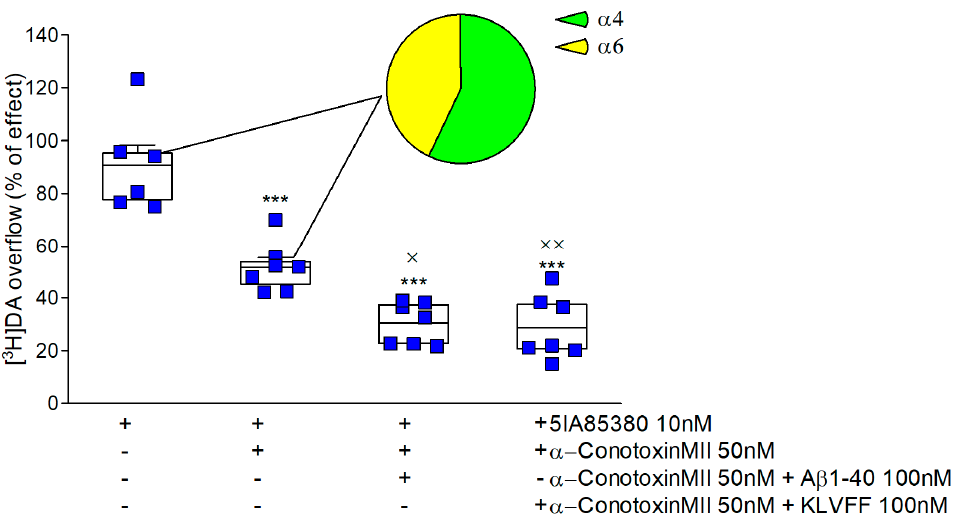
Figure 4. Effect of amyloid peptides on 5IA85380-induced [ 3 H] dopamine release from rat NAc synaptosomes in the presence or in the absence of α -conotoxin MII. Data are mean ± SEM ( n = 7 per group). *** p < 0.001 (compared to 5IA85380); × p < 0.05, ×× p < 0.01 (compared to 5IA85380 plus α -conotoxin MII) one-way ANOVA followed by Tukey’s post hoc test.